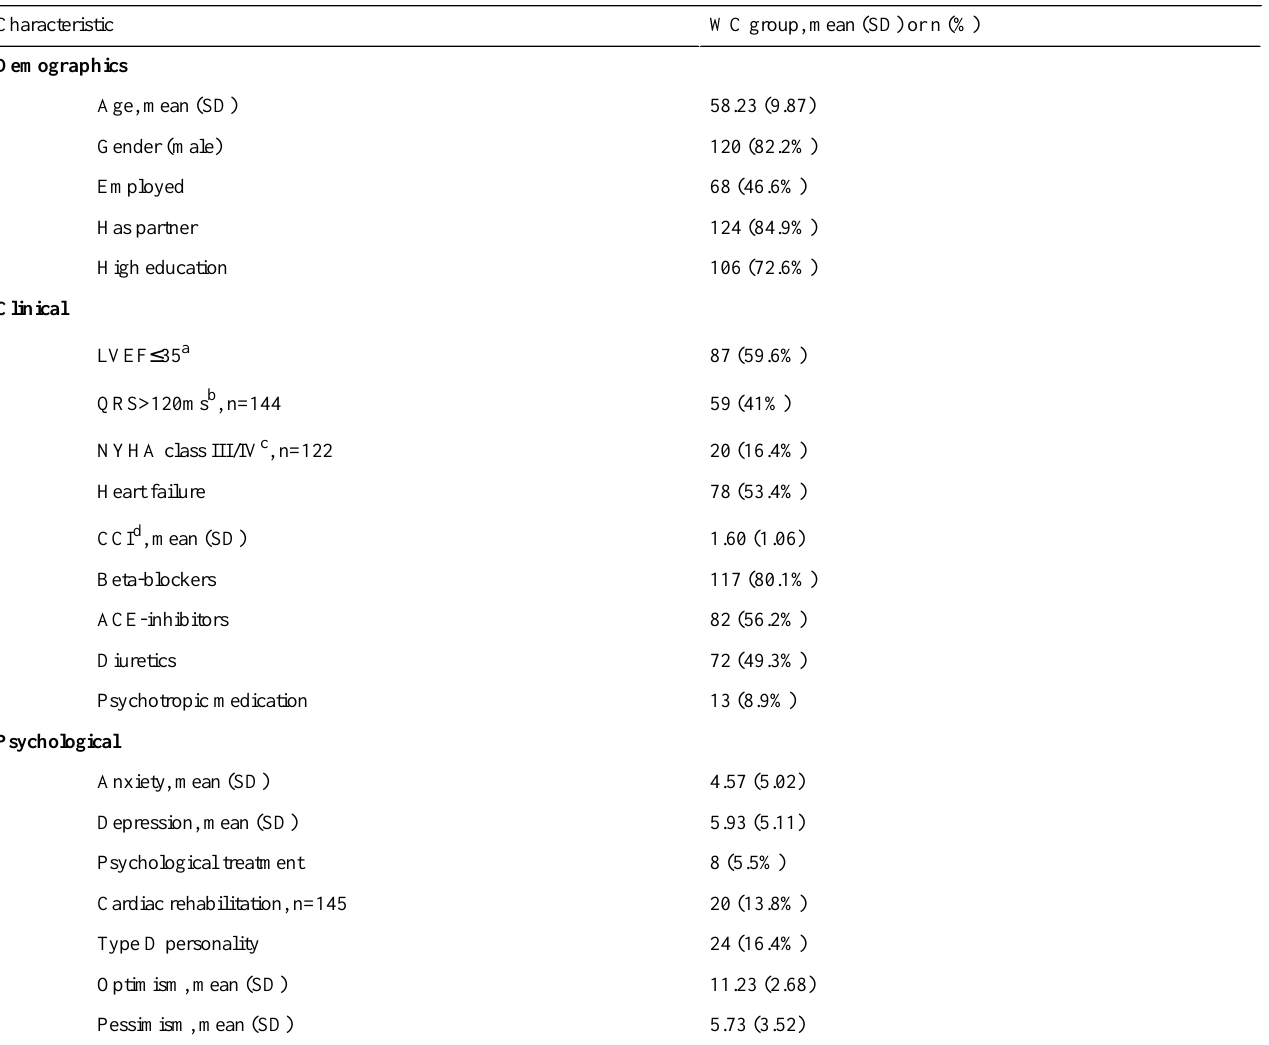
Table 1. Baseline demographic, clinical, and psychological characteristics of patients randomized to the WEBCARE treatment condition (WC;